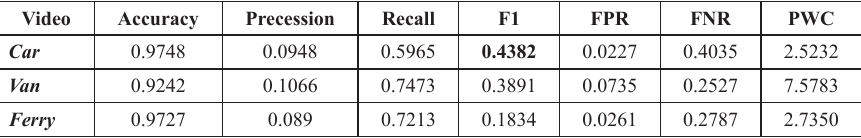
Table 7. Performance metrics results of applying KDE model